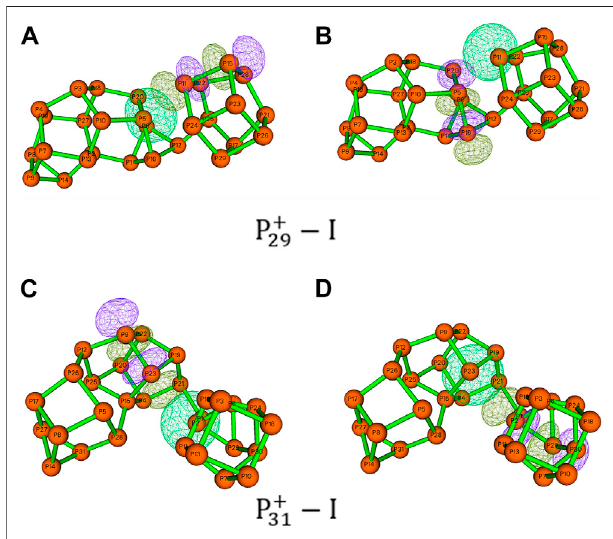
FIGURE 8 | Hyperconjugation of LP(P) → σ *(P – P). The natural bonding orbits were obtained by NBO analysis of (A,B) P + 29 − I and (C,D) P + 31 − I.